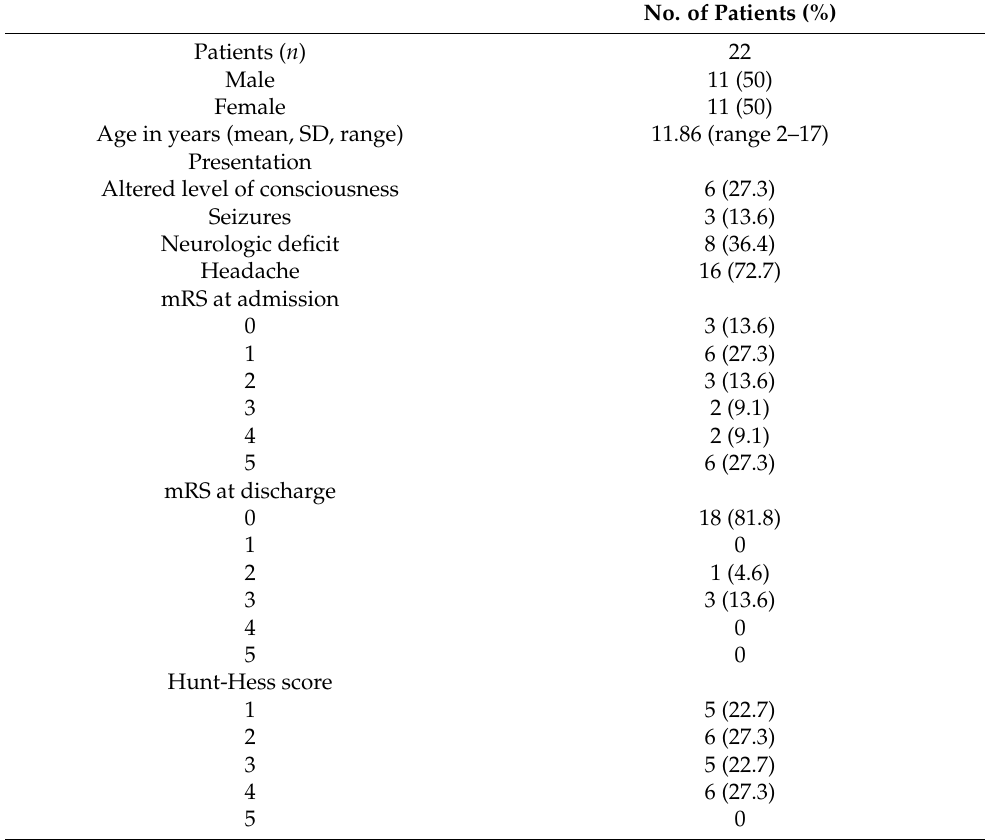
Table 1. Patients’ clinical presentation and clinical outcomes.